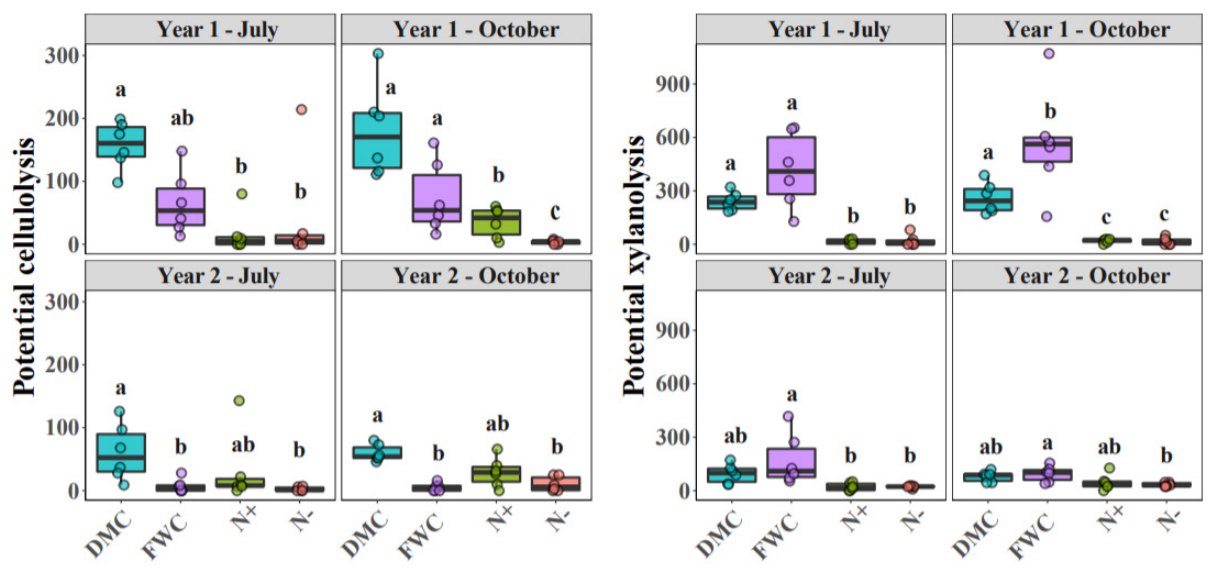
Figure 2. The relative abundance of bacteria with presumptive cellulolytic and xylanolytic potential from almond orchard soil in two years following compost amendment application. N = nitrogen fertilizer, C = control, DMC = Dairy manure compost, FWC = food waste compost. Letters denote statistical differences of p < 0.05 determined by either post hoc Tukey’s honestly significant difference (HSD) test.